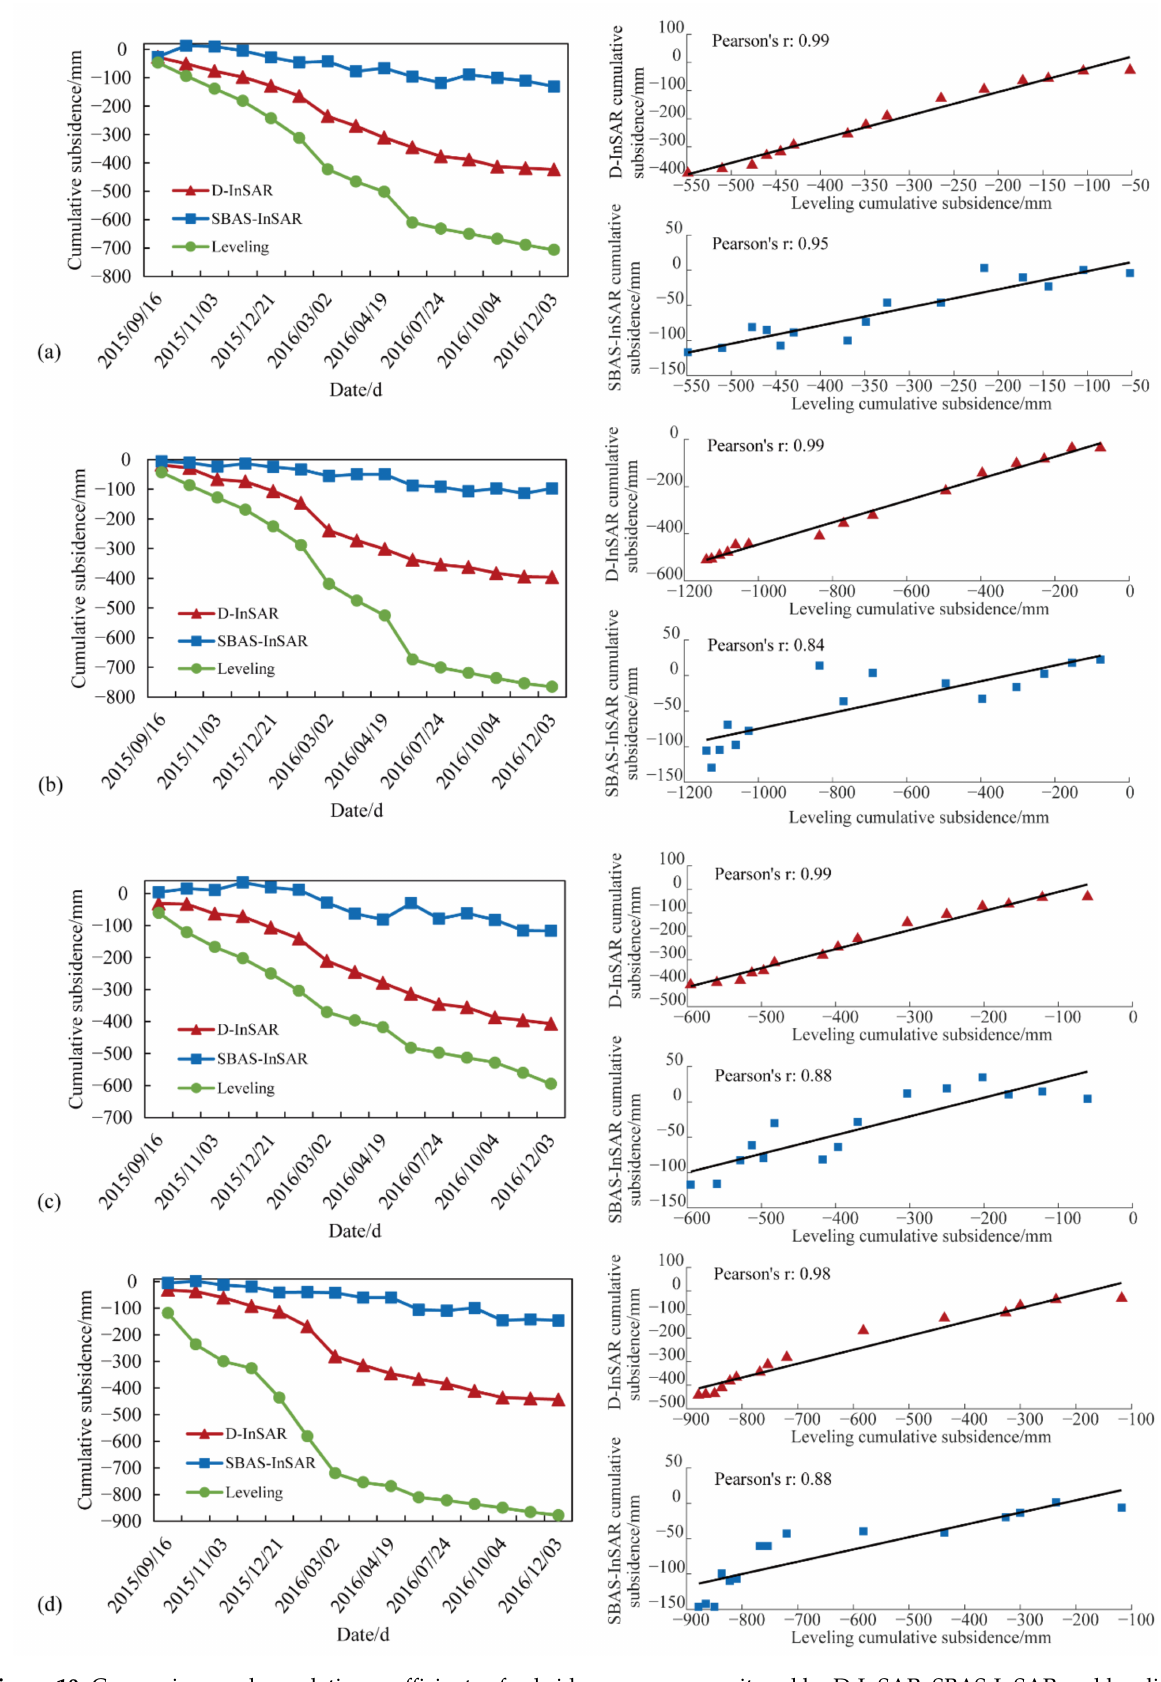
Figure 10. Comparison and correlation coefficients of subsidence curves monitored by D-InSAR, SBAS-InSAR and leveling: ( a ) point H34, ( b ) point H41, ( c ) point Z72 and ( d ) point